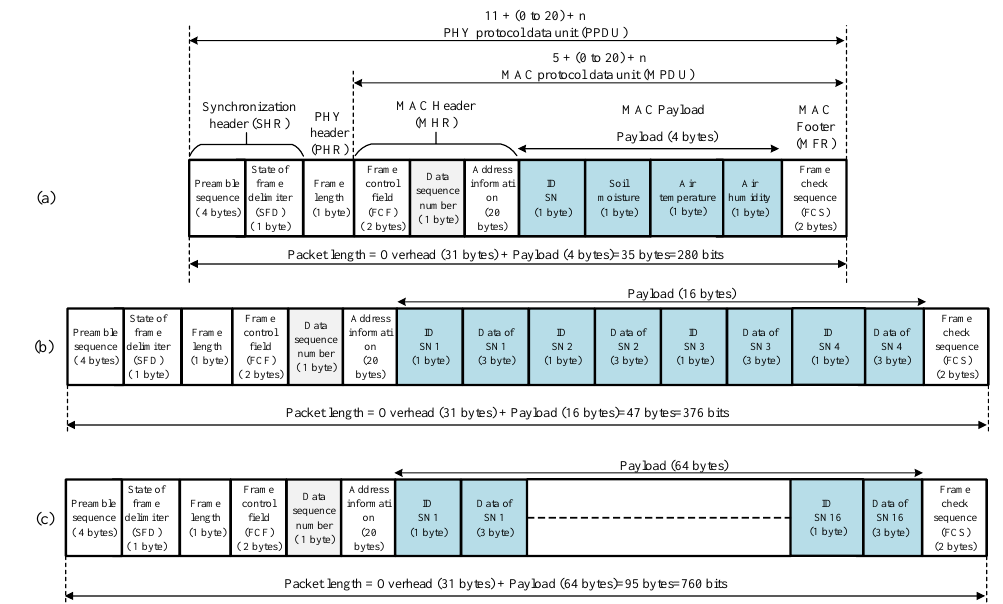
Figure 4. Data packet of XBee S2C is compatible with the Zigbee protocol [44]: ( a ) data packet of each sensor node (35 bytes), ( b ) data packet of each router node (47 bytes), and ( c ) data packet of the main router node (95 bytes).